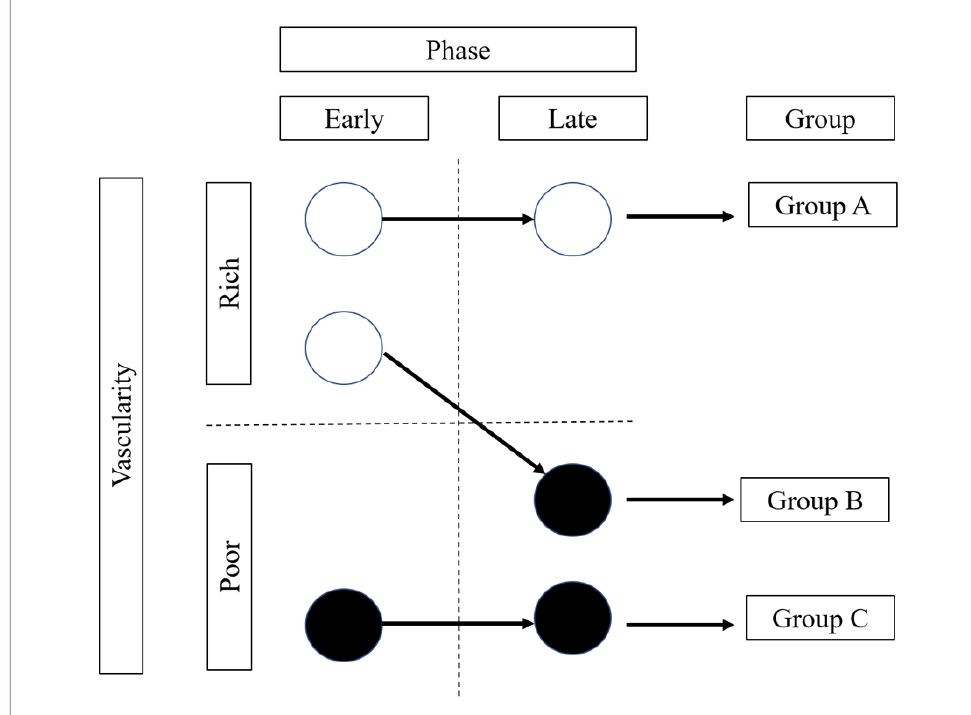
Figure 2. Schematic showing the evaluation of intratumoral vascularity in each phase of con- trast-enhanced harmonic endoscopic ultrasound. Enhancement patterns were identified as early phase and late phase. Patients were divided into two patterns according to intratumoral vascularity: rich vascularity (iso- or hyperenhancement) and poor vascularity (hypo- or nonenhancement). Patients were finally classified into one of three potential groups according to vascularity in early and late phases, with no patients being vascular poor on early-phase imaging and vascular rich on late- phase imaging.